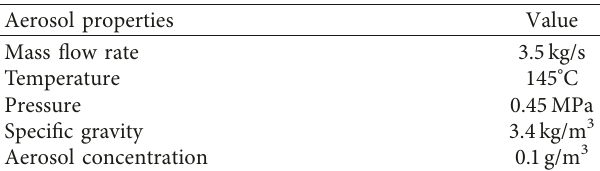
Table 1: Aerosol properties in the containment of the Qinshan Nuclear Power Plant during severe